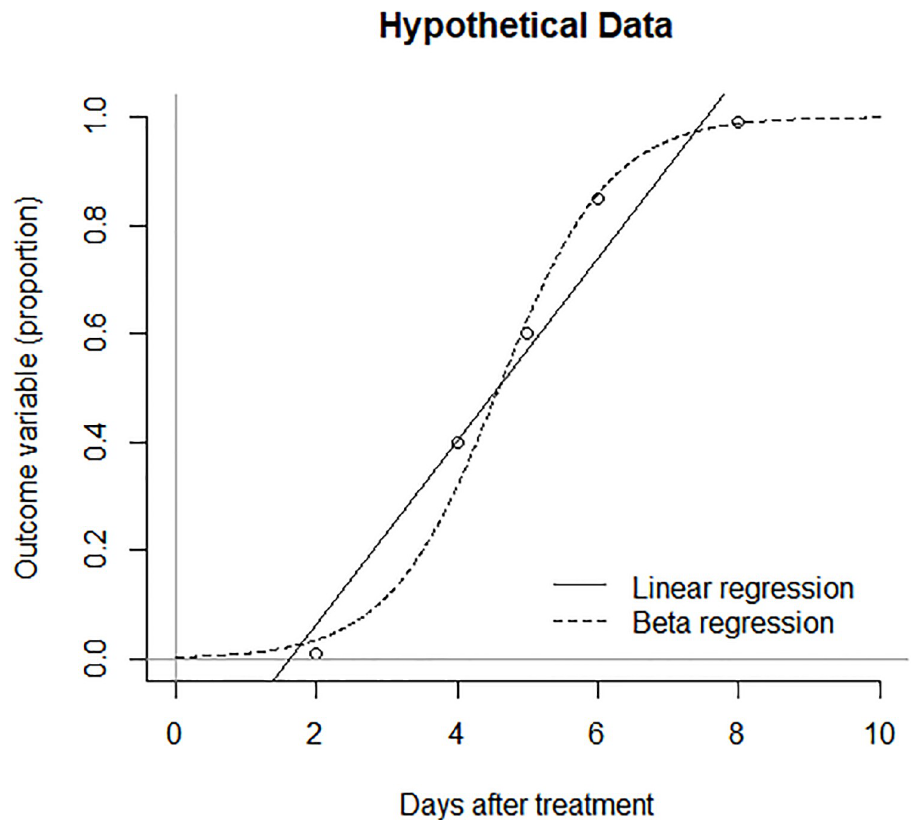
Fig 3. Hypothetical data and estimated regressions to demonstrate a case when beta regression is more appropriate than linear regression.